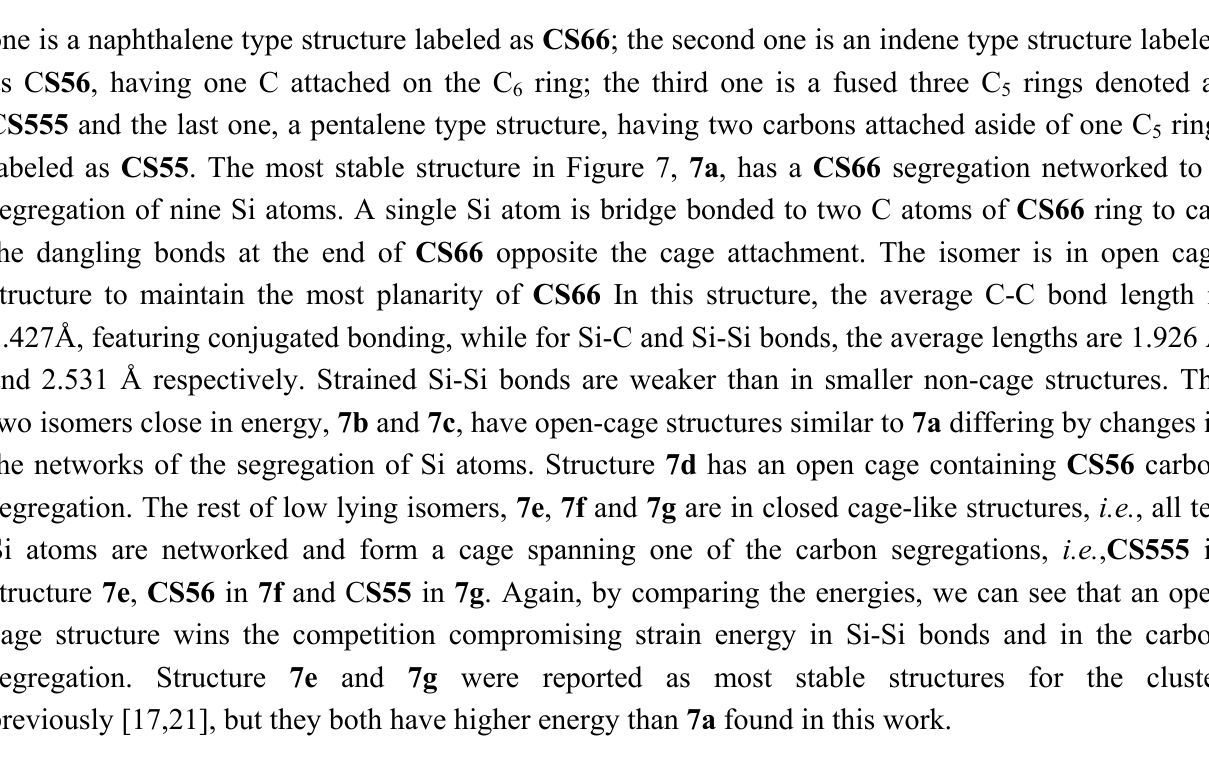
C clusters 10 10